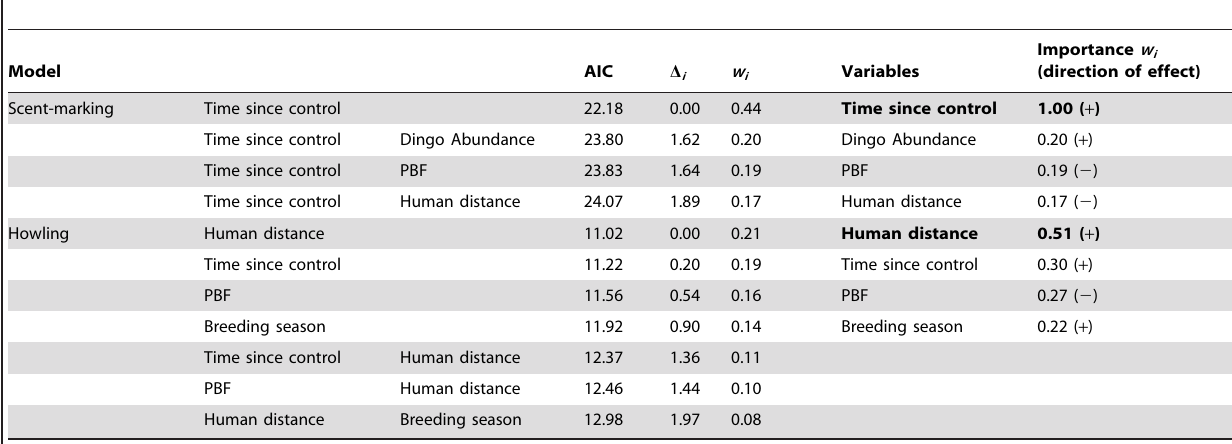
Table 1. Generalized linear models of dingo scent-marking and howling, using best subsets (AIC).